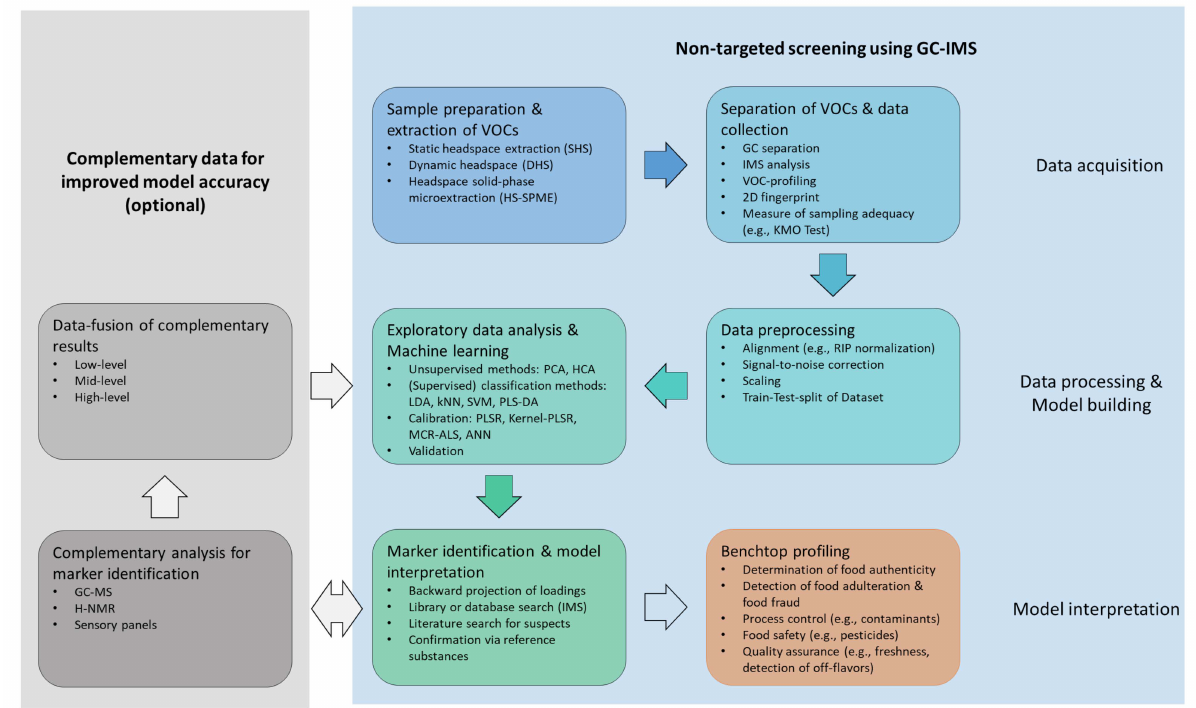
Figure 2. Workflow for non-targeted screening using